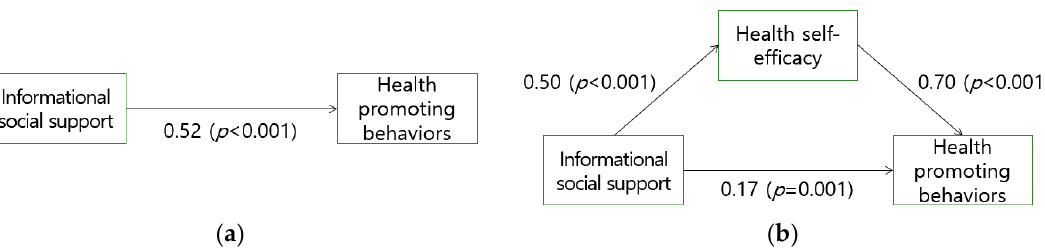
Figure 2. Relationship of informational social support, health self-efficacy, and health-promoting behaviors. ( a ) Direct effect of informational social support on health-promoting behaviors; ( b ) Mediation of health self-efficacy between informational social support and health-promoting behaviors.